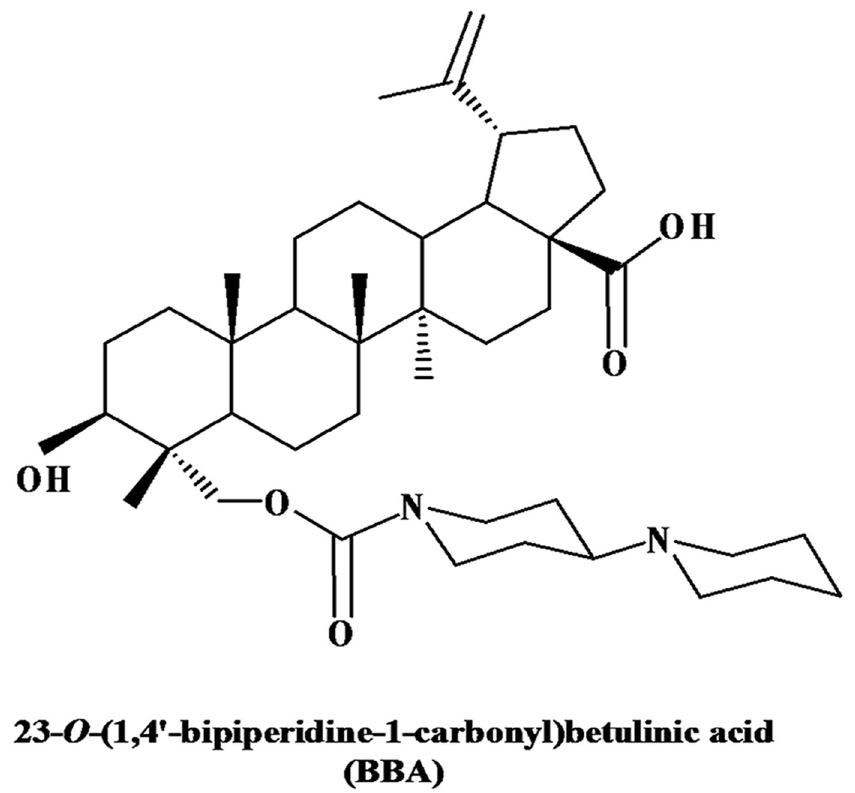
Figure 1. Chemical structure of